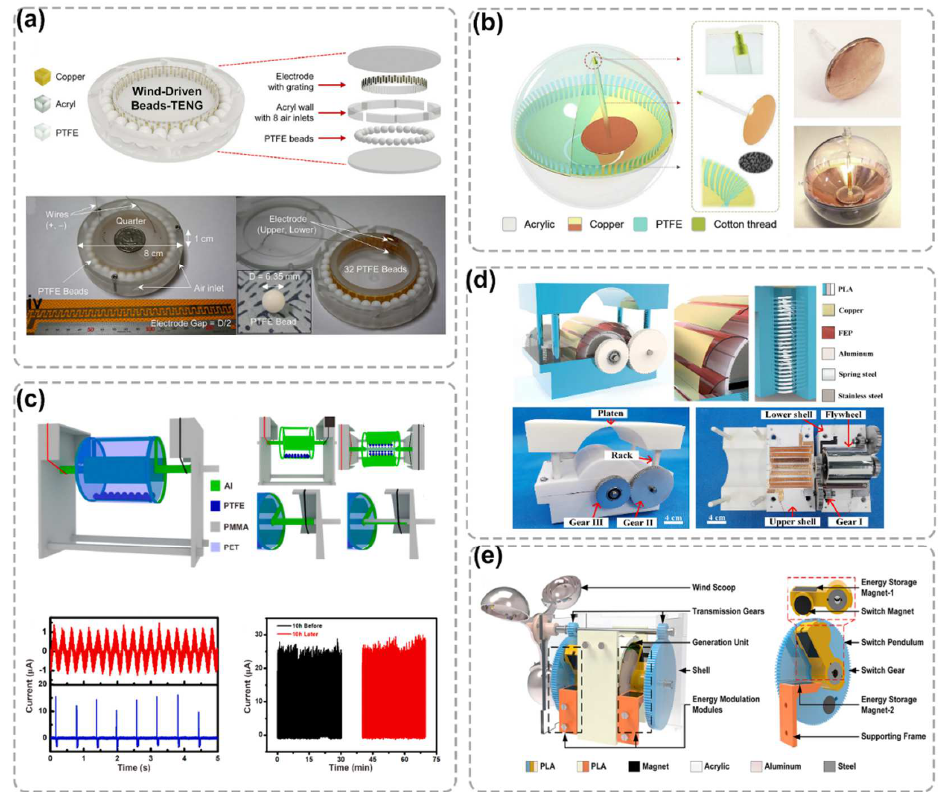
Figure 5. Other structures of WD-TENG. ( a ) WD-TENG based on rolling motion of beads. Reproduced with permission of [38], Copyright 2018, Elsevier. ( b ) A pendulum-spired WD-TENG. Reproduced with permission of [37], Copyright 2019, Elsevier. ( c ) A pulsed cylindrical WD-TENG. Reproduced with permission of [39], Copyright 2021, Elsevier. ( d ) A bidirectional gear transmission triboelectric nanogenerator (BGT-TENG). Reproduced with permission of [23], Copyright 2020, Else- vier. ( e ) WD-TENG controlled energy collection by magnetic switch. Reproduced with permission of [69], Copyright 2021,